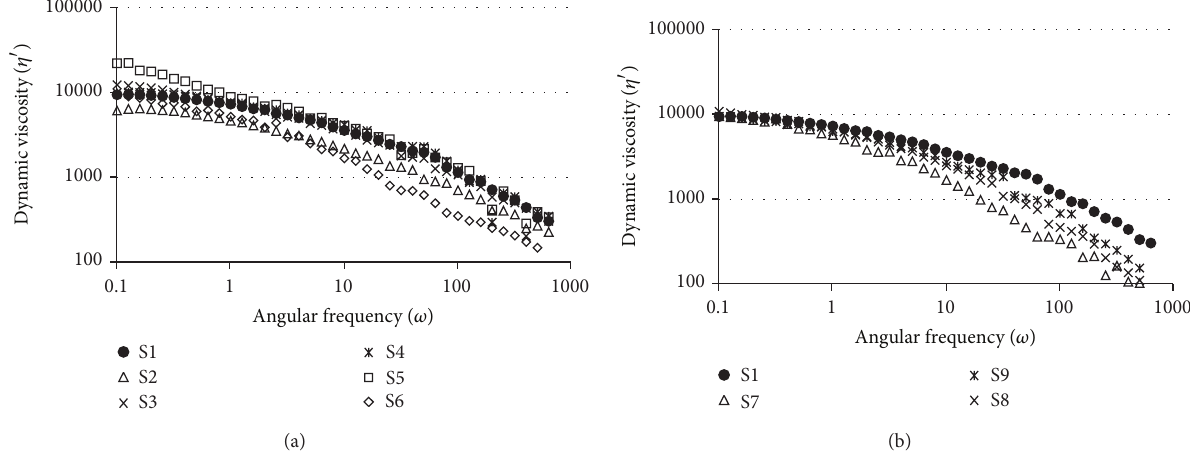
Figure 3: Frequency sweep rheogram for (a) control and blend samples with NIR-reflective pigments and (b) control with NIR reflective and other UV additives.